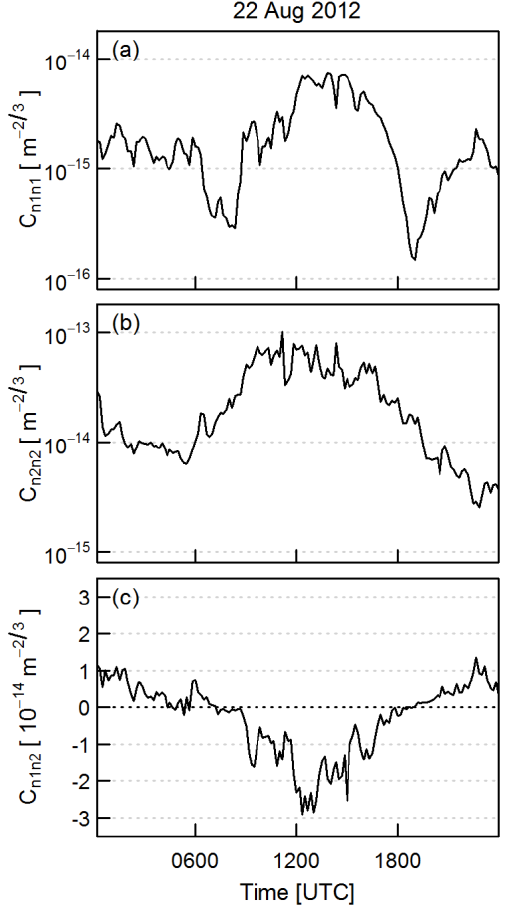
Figure 5. Structure parameters of the refractive index as measured by (a) the BLS and (b) the MWS, and (c) the cross-structure param- eter as measured by the BLS–MWS combination for an example day (22 August